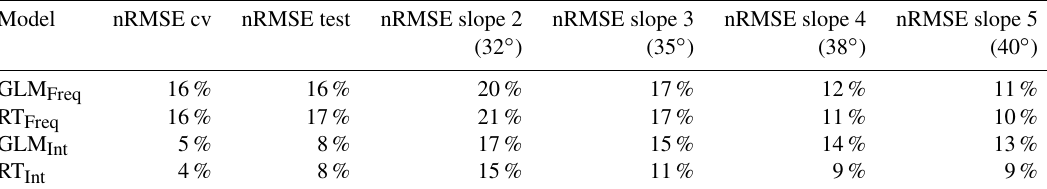
Table 4. Normalized root mean square error (nRMSE) of the generalized linear models (GLM) and the regression tree models (RT) predicting Nrp red (GLM Freq , RT Freq ) and E90 red (GLM Int , RT Int ) with a 10-fold cross-validation (cv) three times and for predictions of the test data set (25% of the data) and linear slopes with varying slope angle (slopes 2–5).